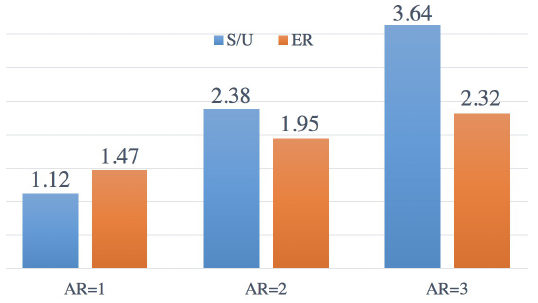
Figure 3. S/U metric and ER metric for the utterances with different accumulation